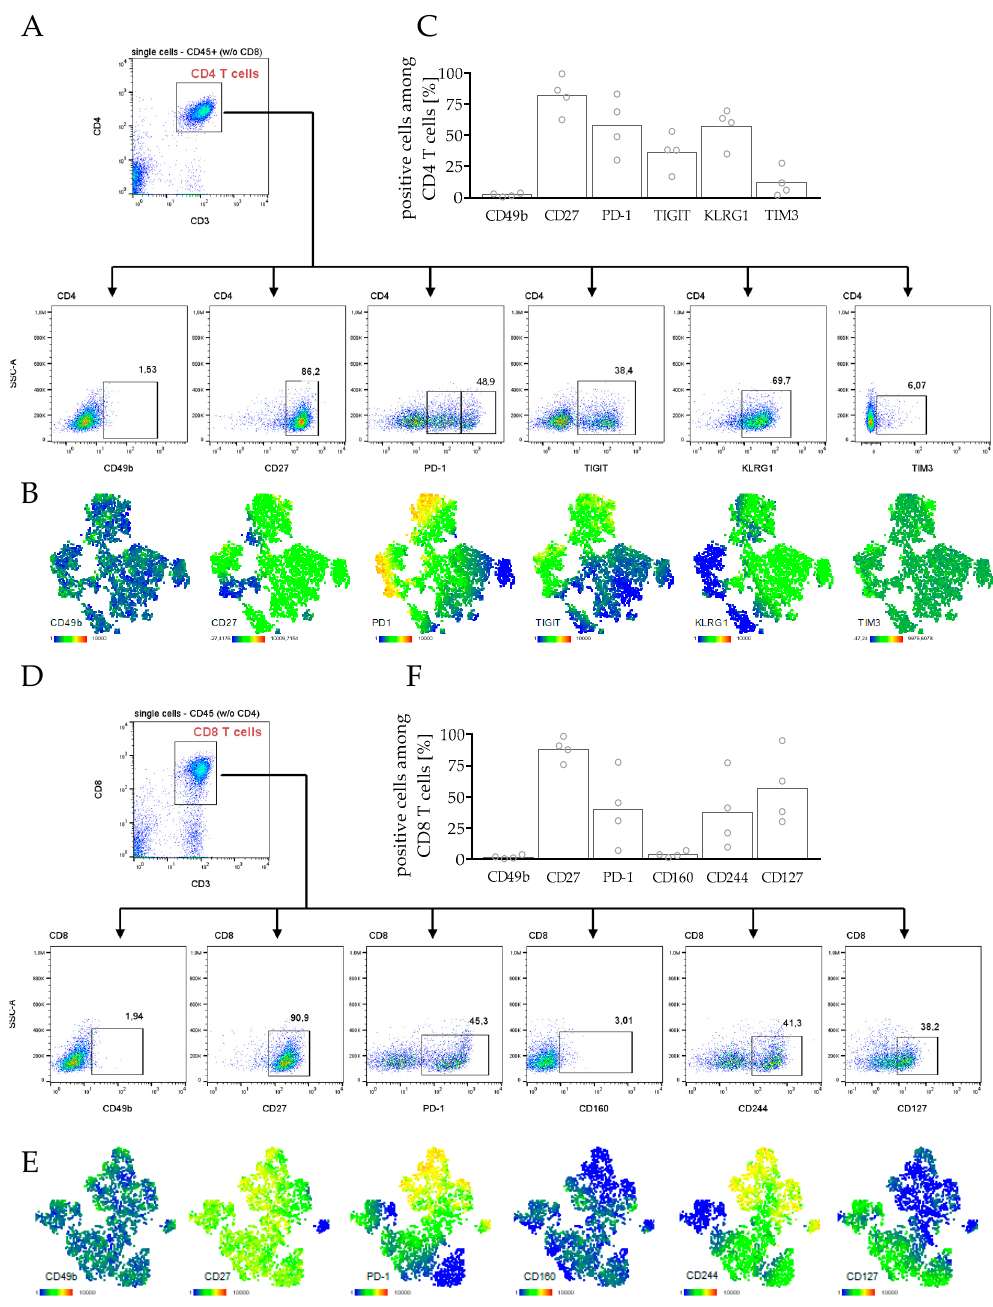
Figure 4. State of exhaustion in CD4 and CD8 T cells in spleens of hPDXs. PDX tumors from breast cancer patients were transplanted orthotopically in humanized NSG mice. Splenocytes were analyzed by flow cytometry. ( A , D ) Manual gating strategy for flow cytometry analysis in ( A ) CD4 and ( D ) CD8 T cells and is compared with t-SNE maps of ( B ) CD4 and ( E ) CD8 T cells, color-coded by the expression of different markers as indicated, to evaluate exhaustion phenotype by staining of CD49b, CD27, PD-1, TIGIT, KLRG1, TIM3 for CD4 T cells and CD49b, CD27, PD-1, CD160, CD244, CD127 for CD8 T cells. t-SNE maps of one exemplary mouse are shown. ( C , F ) Expression of exhaustion markers in ( C ) CD4 and ( F ) CD8 T cells in spleens of all analyzed hPDX are summarized. Each symbol represents one individual mouse (mean, n = 4).